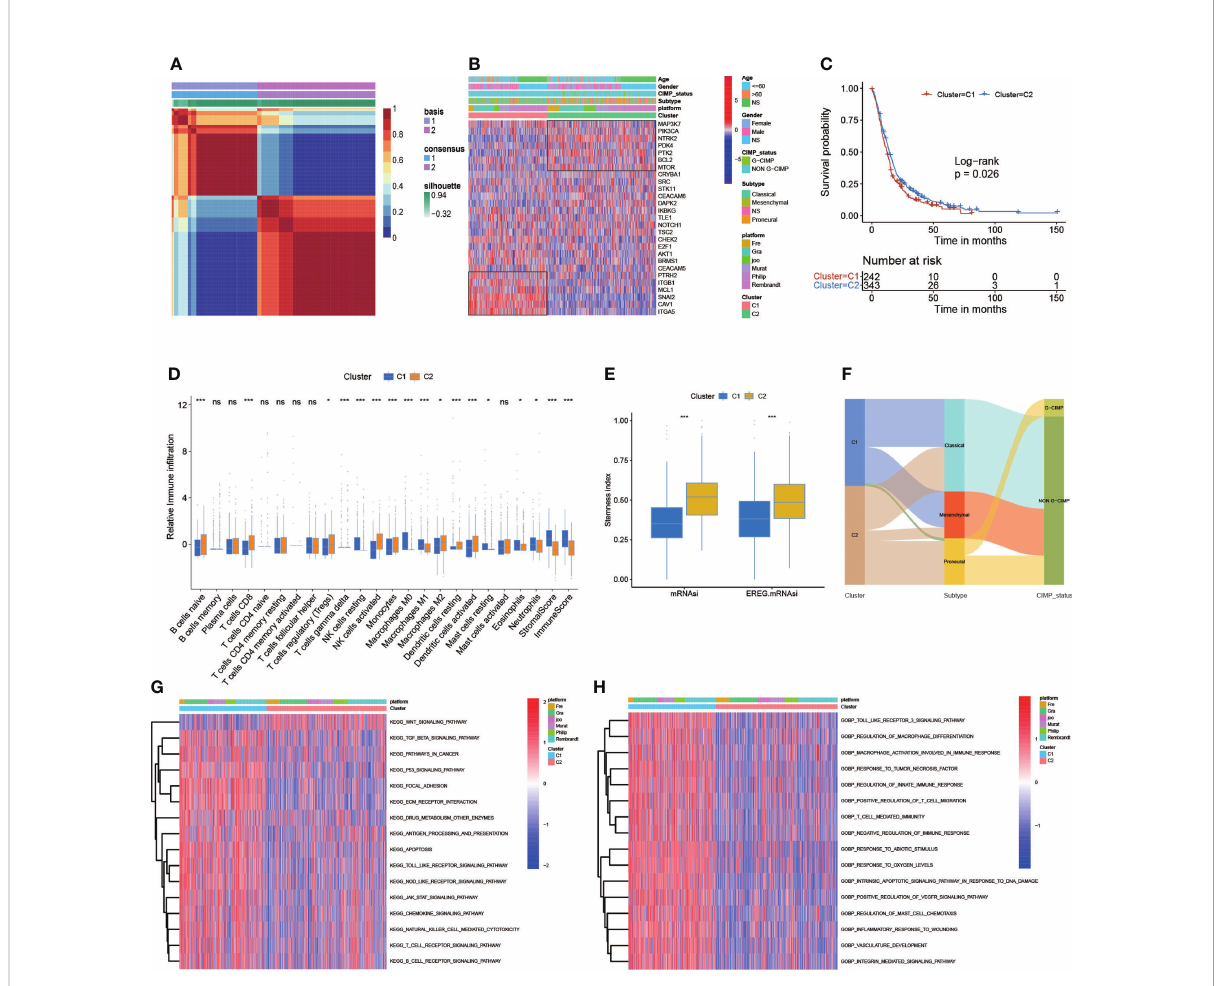
FIGURE 3 Correlation of anoikis pattern with TME, stemness, and clinical traits. (A) The patients with GBM were divided into two distinct gene clusters (C1 and C2) by using non-negative matrix factorization (NMF). (B) The sample annotation of 27 anoikis-related genes in gender, age, platform, IDH status, CIMP_status, and cluster. (C) Survival analyses for the C1 (242 cases) and C2 (343 cases) cohorts (p = 0.026, log-rank test). (D) The abundance of each TME-in fi ltrating cell, stromal scores, and immune scores in C1 and C2 clusters. (E) The stemness index difference of the two gene clusters. (F) The Sankey diagram is about the relationship between C1 and C2 clusters, clinical typing, and cytosine-phosphate-guanine (CpG) island methylator phenotype (G-CIMP). (G, H) KEGG analyses and GO analyses for anoikis-related genes of the two gene clusters. (*p- value < 0.05; **p-value < 0.01; ***p-value <